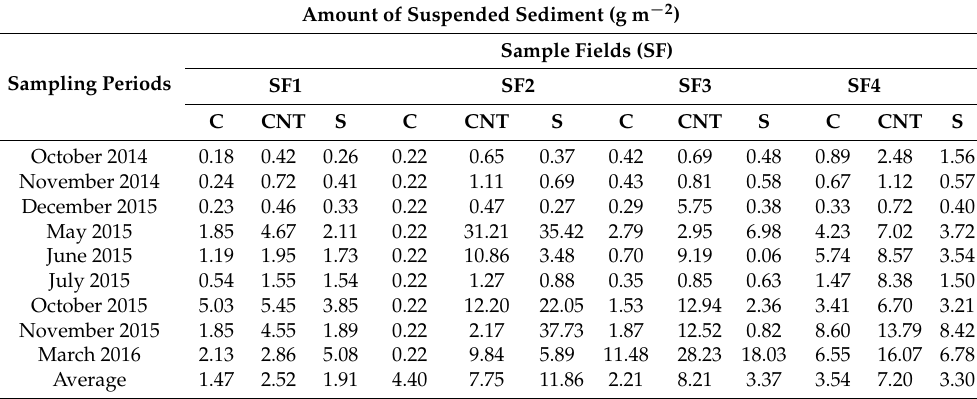
Table 2. Amount of suspended sediment in sample fields.